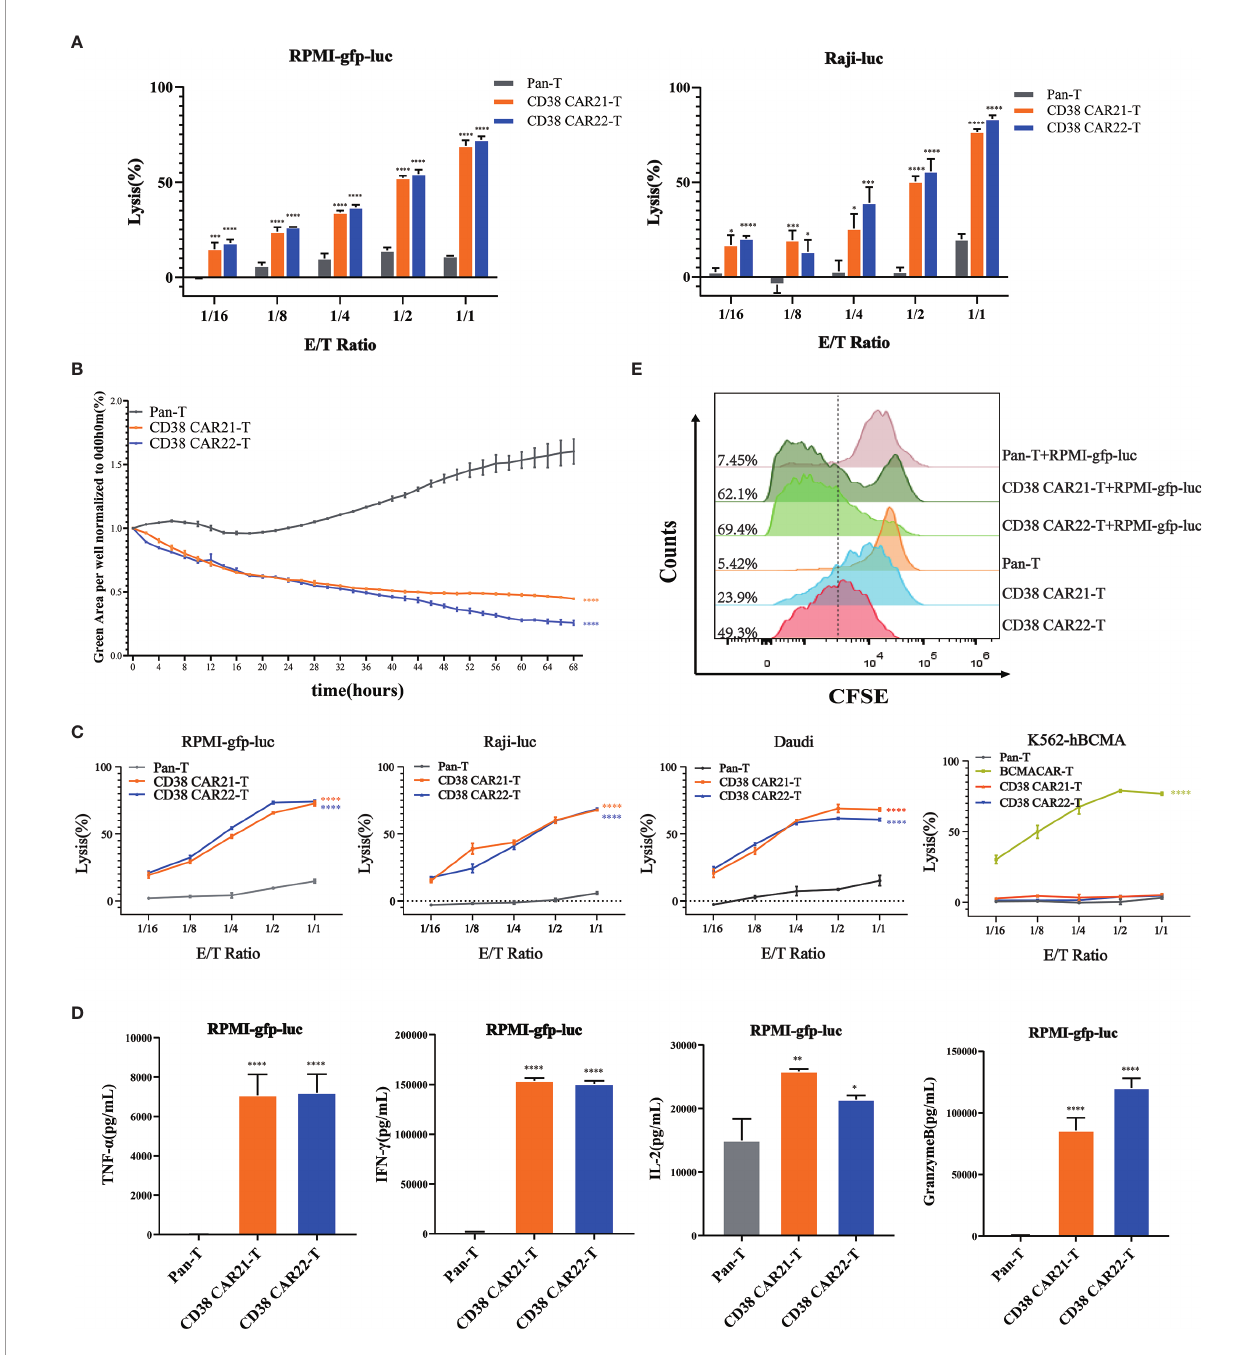
FIGURE 2 | Cytotoxicity and proliferation of CD38 CAR-T cells in vitro . (A) The ability of CAR-T cells to kill tumor cells was measured by luciferase assay. CD38 CAR-T cells or pan-T cells were incubated with RPMI-gfp-luc cells or Raji-luc cells, and the luciferase signal was determined after 12 hours. (B) The ability of CAR-T cells to kill tumor cells was measured by an IncuCyte S3 system. RPMI-gfp-luc cells were incubated with CD38 CAR-T cells or pan-T cells at an E:T ratio of 1:1. Total integrated GFP intensity per well was assessed as a quantitative measure of live, GFP + tumor cells. The values were normalized to the starting values. (C) The ability of CD38 CAR-T cells to kill tumor cells was determined by fl ow cytometry. CD38 CAR-T cells or pan-T cells were incubated with RPMI-gfp-luc cells, Raji-luc cells, Daudi cells or K562-hBCMA cells for 12 hours. (D) CD38 CAR-T cells were incubated with RPMI-gfp-luc cells for 12 hours, and the secretion of cytokines was measured with a fl ow cytometry-based CBA kit. The graph shows the secretion of TNF a , IFN- g , IL-2 and granzyme B. (E) The proliferation of CD38 CAR-T cells. The proliferation ability was measured by the CFSE-based assay. Data were obtained from three replicates and are presented as the mean ± SEM (n=3). *indicates p value < 0.05; **< 0.01; ***< 0.005 and ****< 0.001, comparison of two groups was performed by Student ’ s t-test. TNF- a , tumor necrosis factor a ; IFN- g , interferon g ; IL-2, interleukin